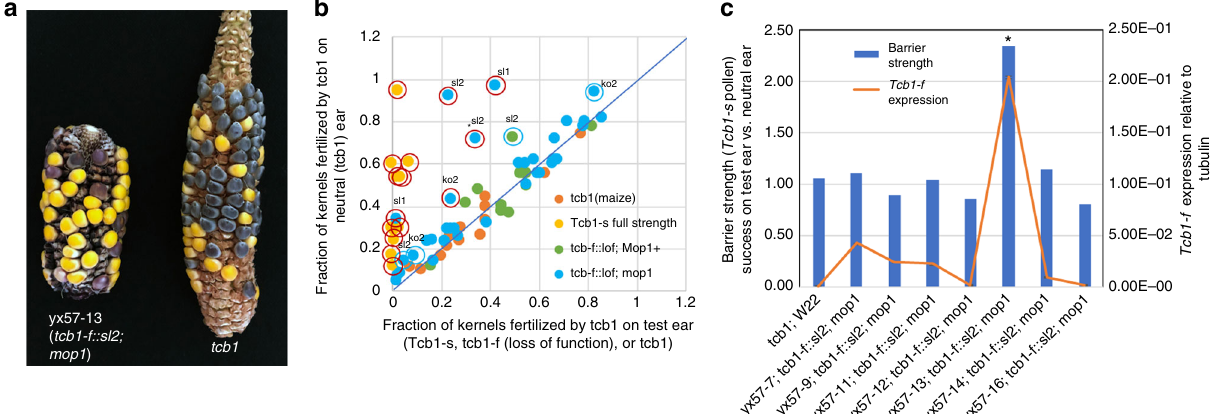
Fig. 3 Reversion of tcb1-f loss-of-function. a Revertant ear (marked by asterisk in b and c ) pollinated by a mix of tcb1; R1-sc and Tcb1-m ; r1 pollen showing higher frequency of yellow kernels on the test ear than the tcb1 control ear. b Results of mixed pollination tests on four genotypes: tcb1 , Tcb1-s , tcb1-f ( loss-of- function(lof)) alleles, and tcb1-f(lof) mop1 double mutants. The percentage of kernels from tcb1 pollen on the test ear are plotted on the x -axis and the percentage of kernels from tcb1 pollen on the control tcb1 ear on the y -axis. Equal percentages in the two ears indicates no barrier (line with slope = 1). Red circles indicate ears with signi fi cantly fewer tcb1 kernels in the test ear vs. the control ear at p < 0.0001 and blue circles at 0.0001 < p < 0.01 (two-tailed Fisher exact test). The loss-of-function line is indicated for each revertant. c Tcb1-f/PME38 gene expression level and barrier strength. Barrier strength is expressed as the ratio of kernels from Tcb1-s vs. tcb1 pollen on the test ear vs. the control tcb1 ear (columns), with a fraction of 1.0 indicating no barrier and signi fi cantly higher values a functional barrier. Tcb1-f/PME38 RNA levels are expressed as relative to the tubulin control gene (orange line). Error bars in c equal the standard error of the mean. Individual pedigree numbers are given for loss-of-function plants tested for reversion in a and c . Source data